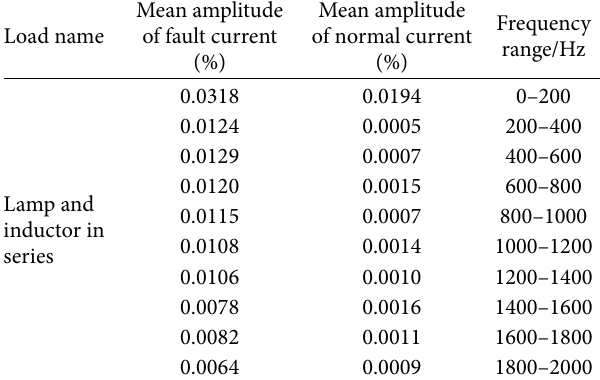
Table 2: Frequency domain feature values of lamp and inductor in series load circuit.